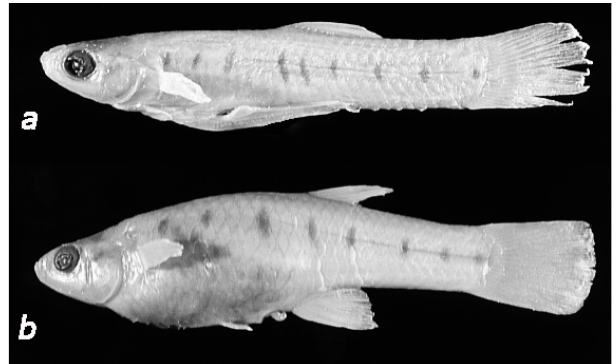
Fig. 3. Cnesterodon decemmaculatus . MLP 5623, General Fernando Oro, Río Negro, Argentina: (a) male, 20.6 mm SL; (b) female, 31.9 mm